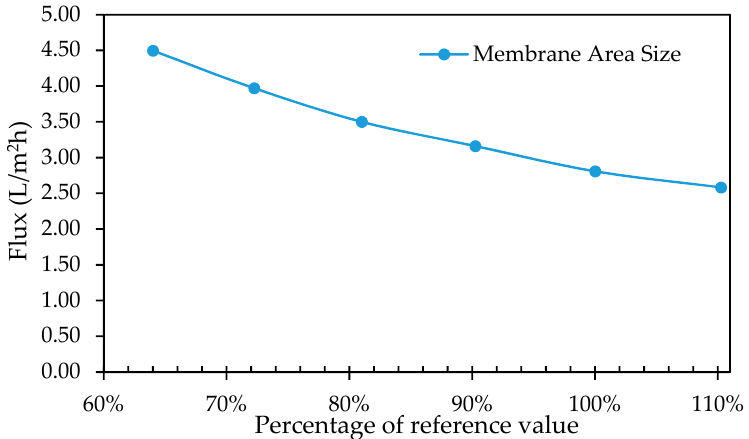
Figure 15. Total permeate flux leaving the module plotted as a function of the percentage of the reference value for surface area.